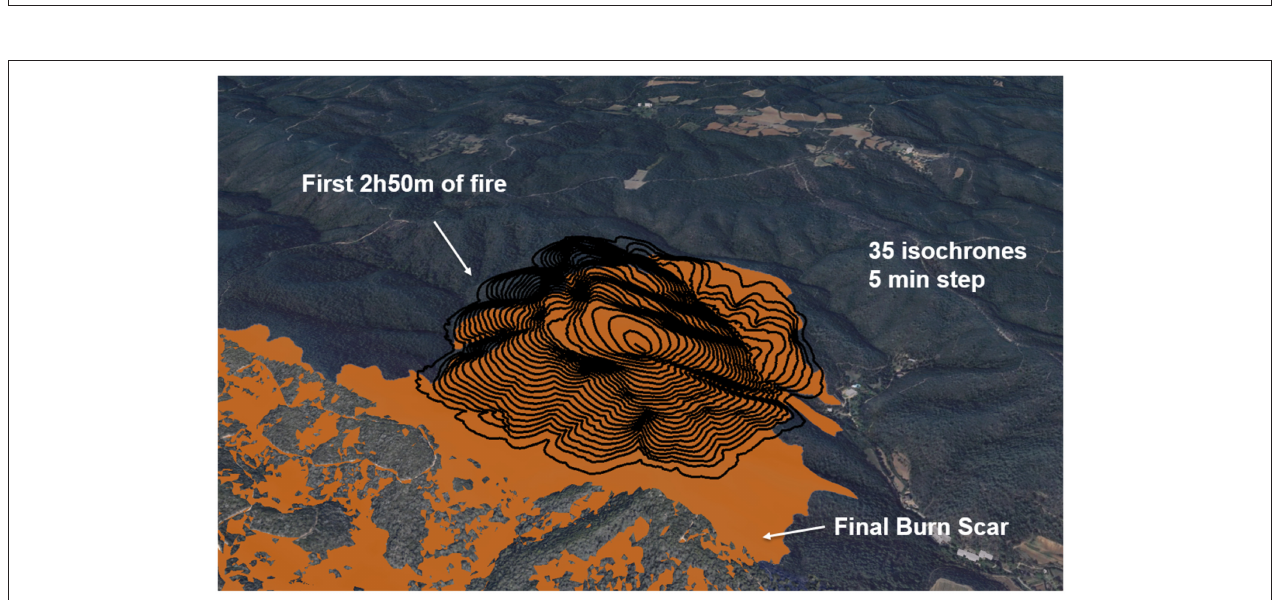
FIGURE 5 | Farsite validated reconstruction of Vall-llobrega fires for the initial 170 min. Black lines are 35 isochrones at 5 min frequency. Orange solid contour is the satellite-based final scar (source: ICGC, 2018).